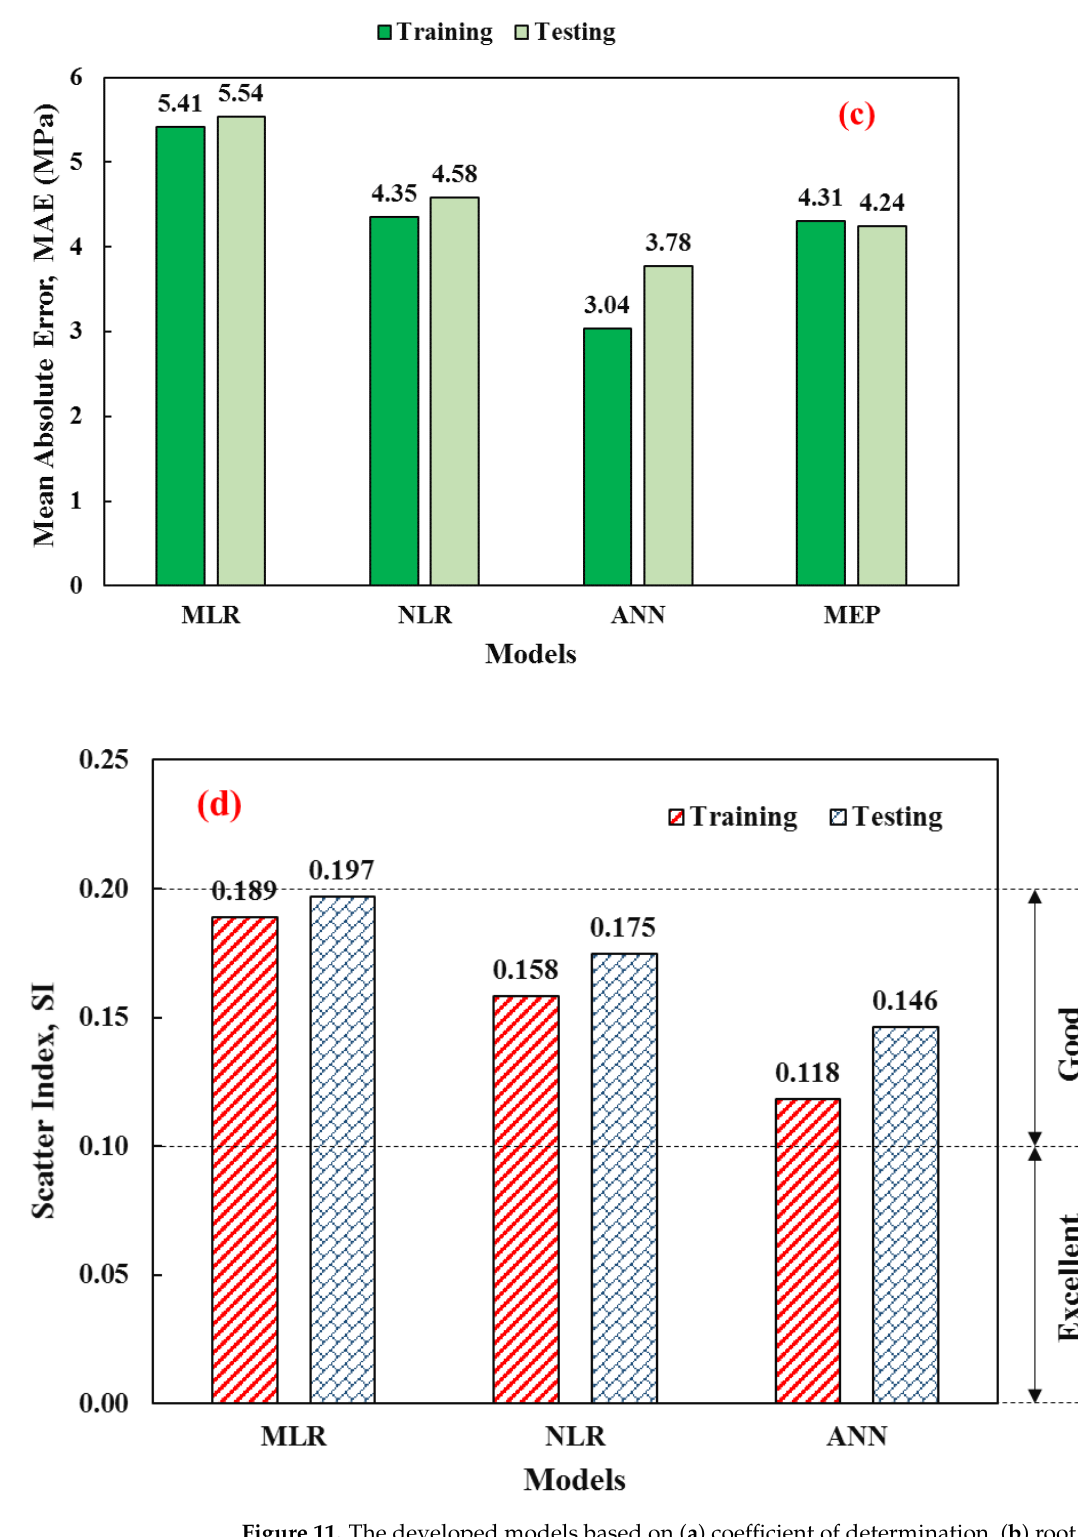
Figure 11. The developed models based on ( a ) coefficient of determination, ( b ) root mean squared error, ( c ) mean absolute error, ( d ) scatter index.